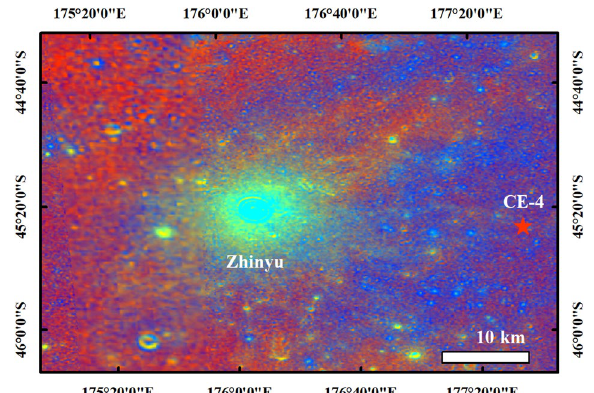
Figure 7. The color ratio image 43,44 from Clementine UVVIS data at the CE-4 landing site, showing a slight impact ray to the CE-4 landing site (red star) from the Zhinyu crater. The map was created in ESRI ArcMap 10.2 (https:// deskt op. arcgis. com/ zh- cn/